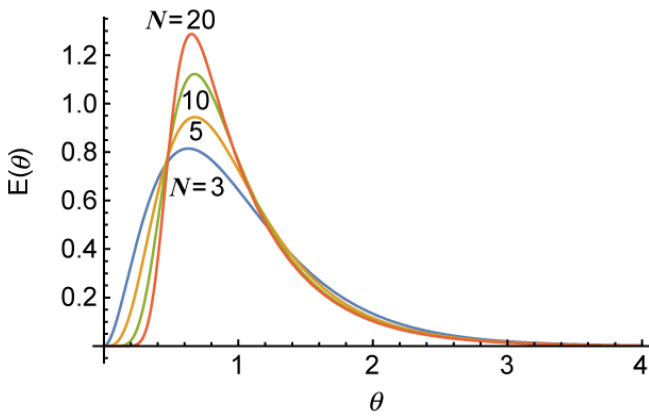
Figure 8. Calculated residence time distribution for the cases with the total number of tanks, N = 3, 5, 10 and 20